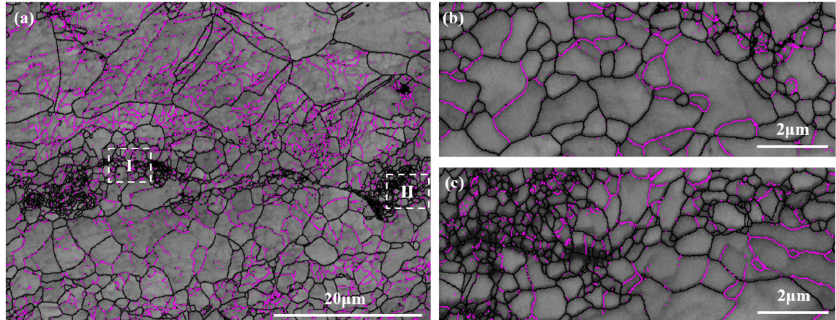
Figure 13. Grain boundary map of the Cu-ETP ultrasonic welded joint ( a ), grain boundary map in zone Ⅰ ( b ) and Ⅱ ( c ). Figure 14 is a statistical graph of the grain size and misorientation of the welded joint. The grain size of copper is obviously reduced after ultrasonic welding, and the average grain size is 1~2 µ m. The grain size is relatively concentrated, and most of the grain size is in the range of 1~10 µ m, which shows that ultrasonic welding has the effect of grain refinement (Figure 14a). It can be seen from the misorientation statistical graph that the misorientation has changed from high to low. This shows that the small-angle grain boundaries increase after ultrasonic welding, and the large-angle grain boundaries decrease, which corresponds to Figure 13 (Figure 14b).